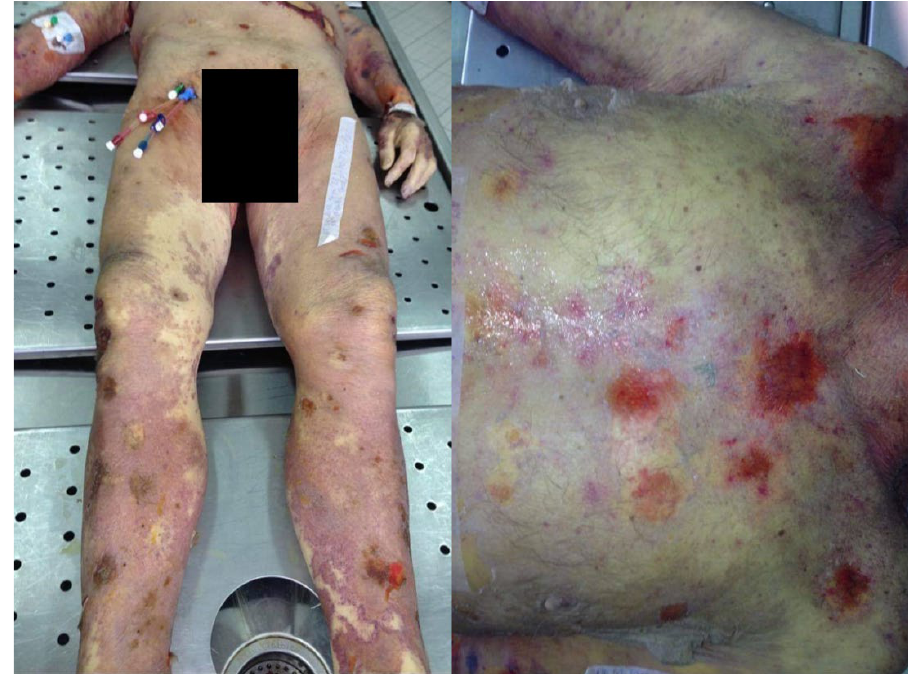
Figure 1. Multiple petechial hemorrhages on the body surface